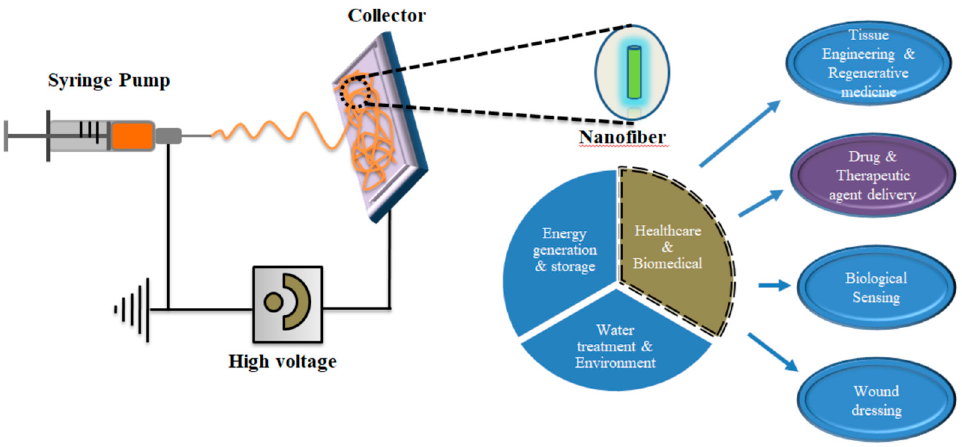
Figure 1. Schematic representation of a traditional electrospinning process and various healthcare and biomedical applications of nanofibers.